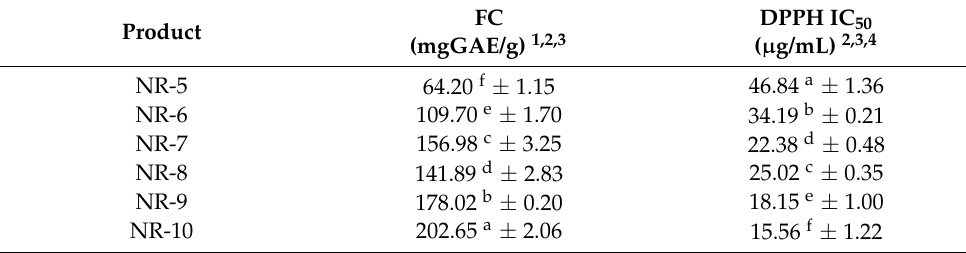
Table 7. Folin–Ciocalteu and DPPH results for Z. officinale rhizomes from experimental